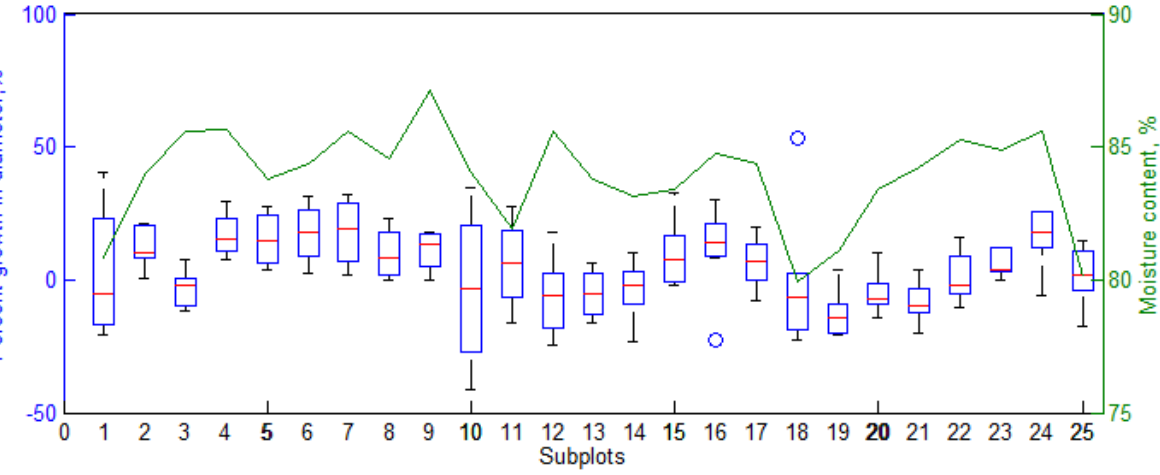
Figure 8. Percent growth of oil palm trunk diameter based on data from 2014–2018 (box-and-whisker plots) and soil moisture content in the 0–50 cm layer (green line) in the 25 subplots at Sebungan Estate. The number of oil palms per subplot ranged from 4 to 10.